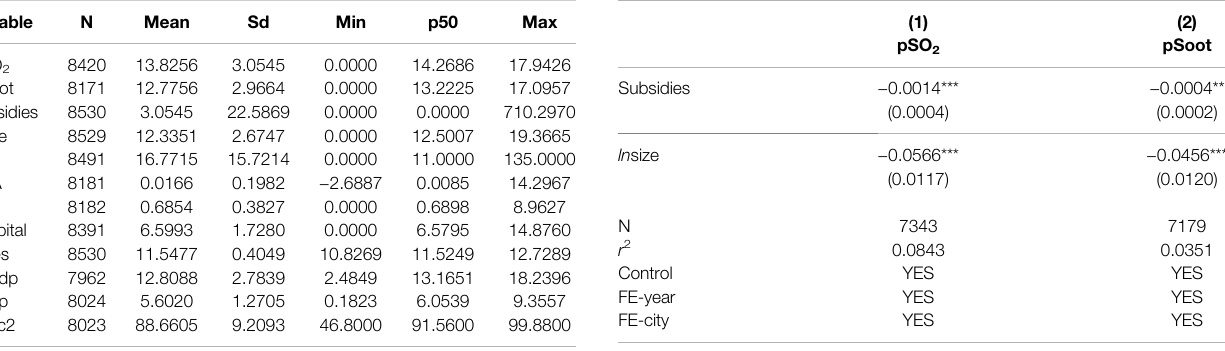
TABLE 1 | Descriptive statistical analysis.